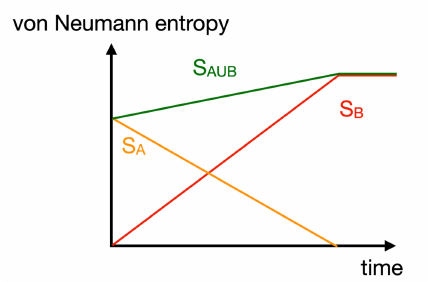
Figure 7 . Qualitative behavior of S A (entropy of black hole), S B (entropy of radiations) and S A ∪ B . Apparent departure from the Page curve can be cured by taking into account the confined sector (region C ); see figure